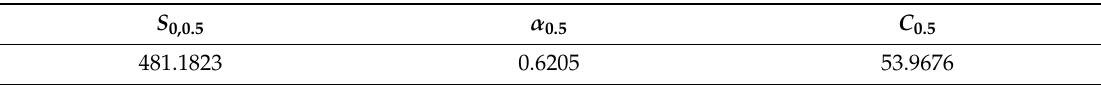
Table 5. Model parameters.